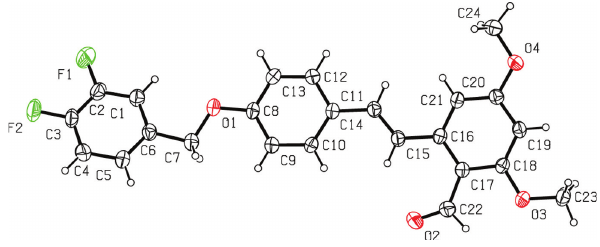
Figure 1: X-ray crystal structure of the title molecule.